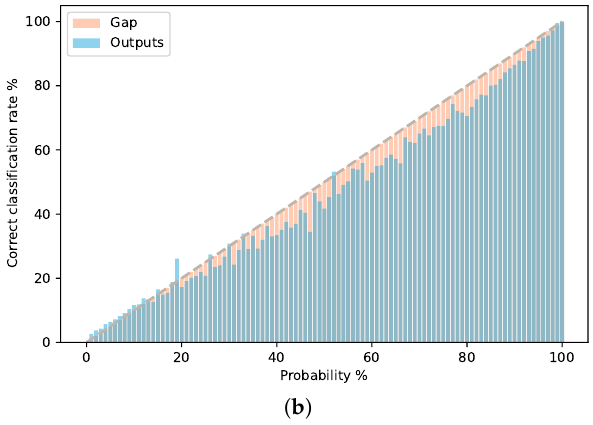
Figure 9. Model calibration. Empirical rate of correct prediction by predicted confidence. We quantize the predicted confidence into 100 bins for visualization purposes. For a perfectly calibrated prediction, the blue histogram would exactly follow the orange line. We observe that a simple post-processing step can considerably improves calibration. ( a ) No calibration, ECE = 1.4%. ( b ) Calibration, ECE =